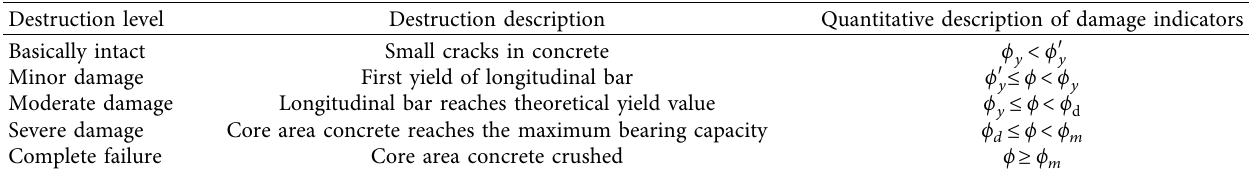
Table 2: Damage grade of